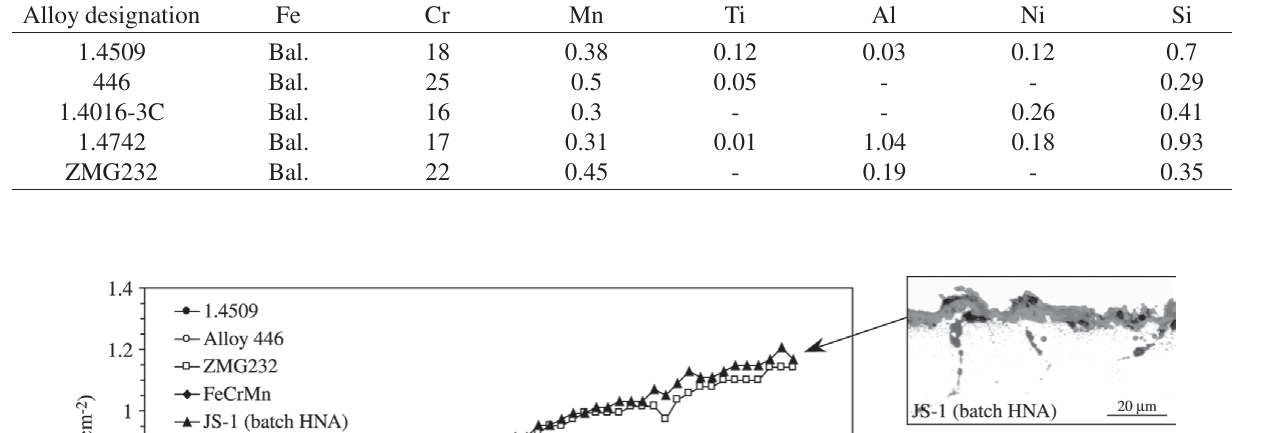
Table 2. Chemical compositions of the studied commercial ferritic steels (Mass.-